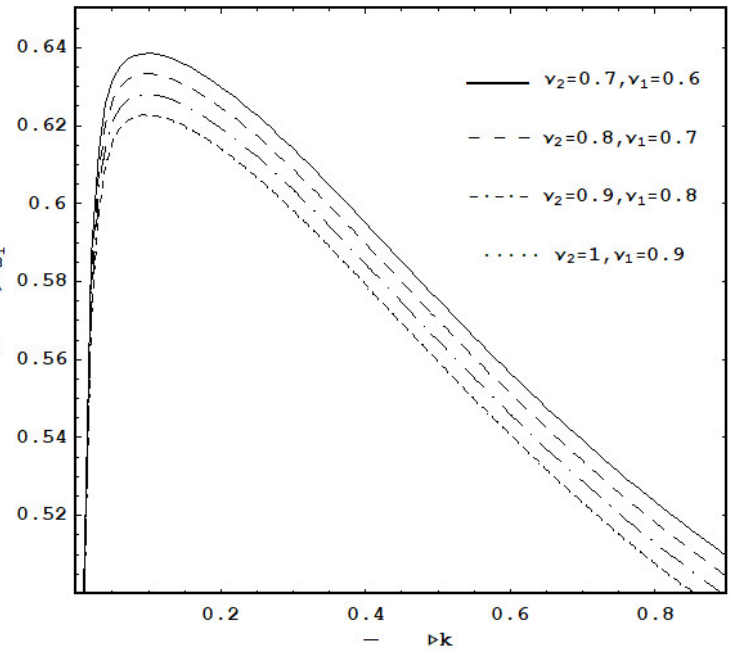
Figure 13. Variation of the growth rate ω i with the wavenumber k for different values of the kinematic viscosity ν 1 , ν 2